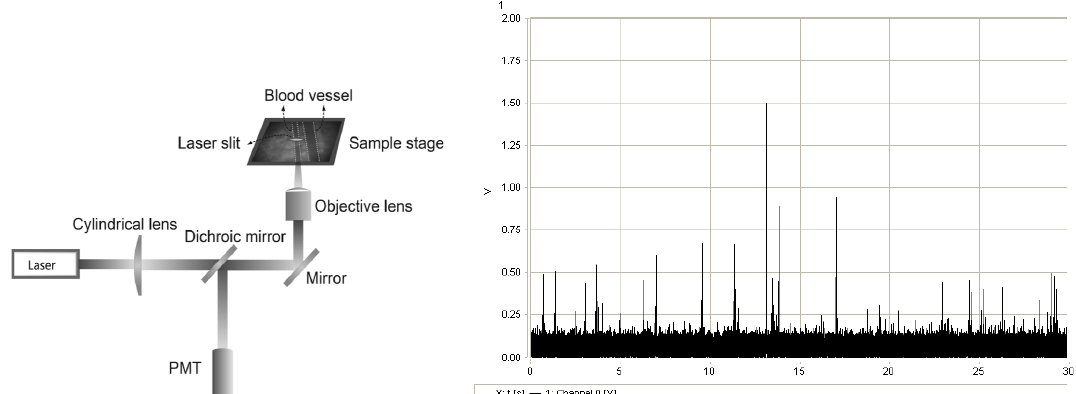
Fig. 3. Fluorescence signal from labeled circulating cells was recorded by IVFC and the detected trace of labeled circulating liver tumor cells. The peak within the trace indicates that a labeled cell passes through the slit of light and thus gives a burst of °uorescence.